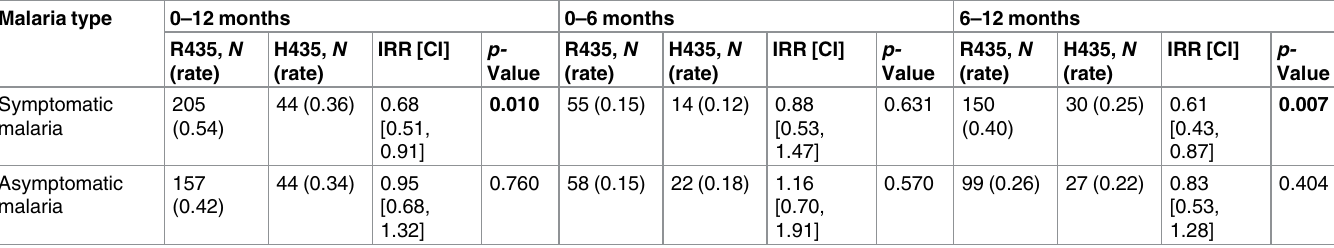
Table 4. The cumulative number of malaria infections recorded from birth to 12 months of